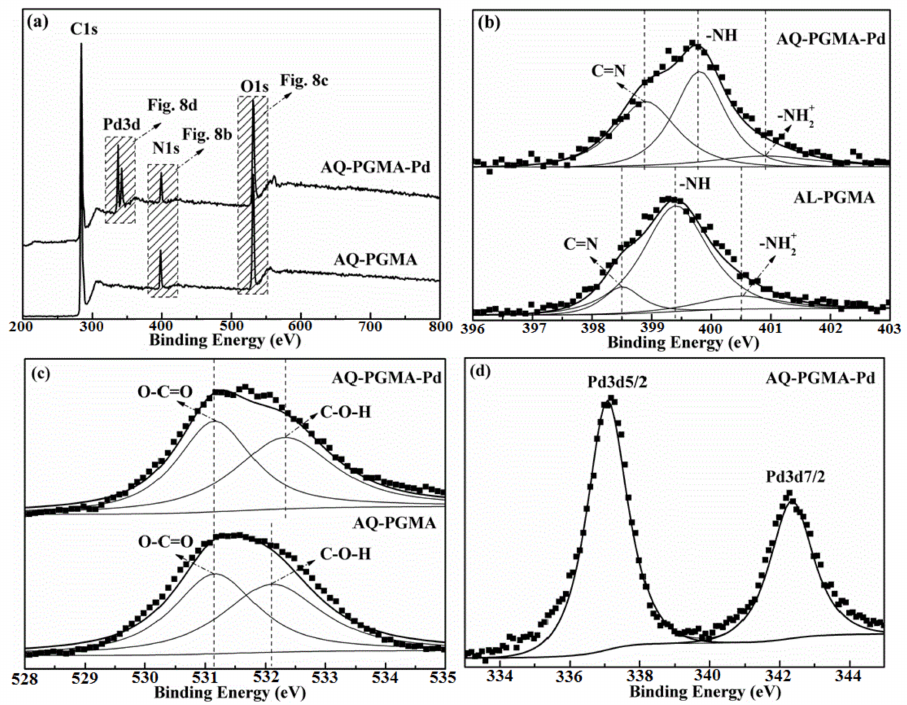
Figure 8. XPS survey scan ( a ), N 1s spectra ( b ), O 1s spectra ( c ) of AQ-PGMA and AQ-PGMA-Pd and Pd 3d spectra ( d ) of